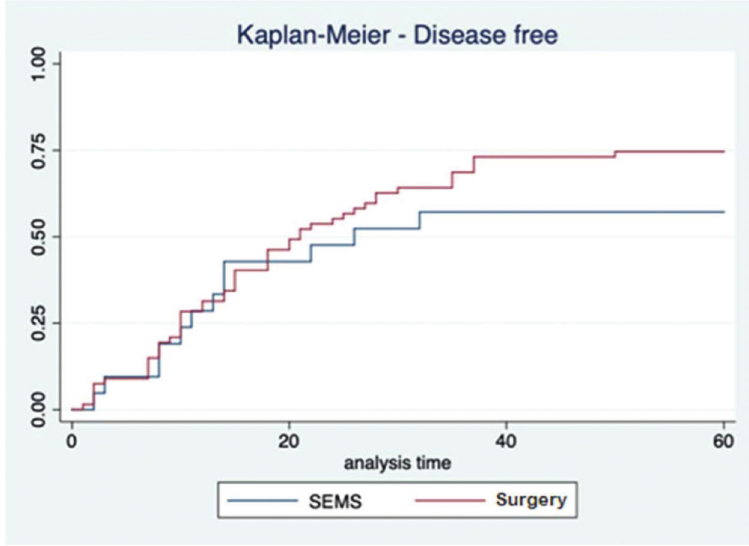
Figure 4 - Kaplan-Meier disease-free survival curve comparing SEMS and emergency